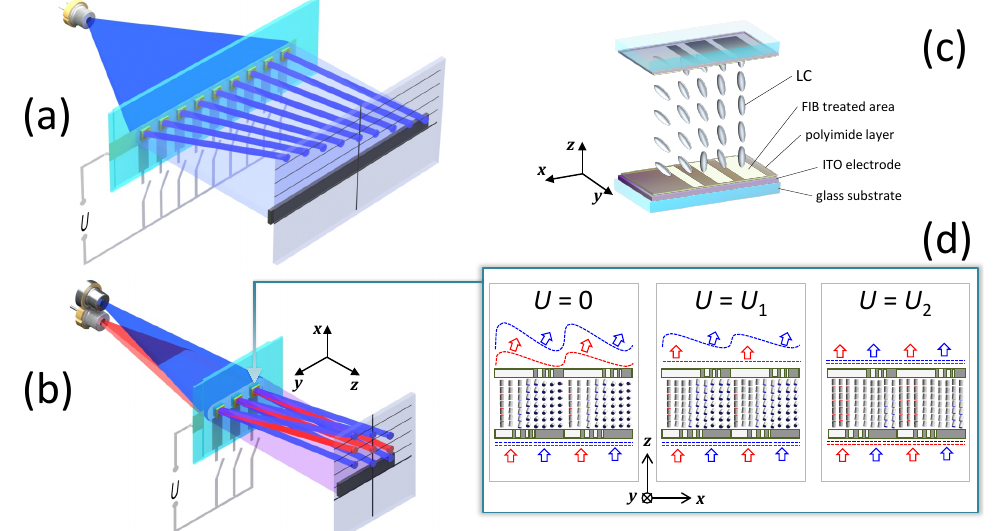
Figure 1. Advantages of multiplexed beam-steering elements based on LC-metasurfaces. Schematic of an array of 9 electrically controlled elements of different periods for parallel +1 order diffraction deflection at 9 different angles ( a ). Schematic of an array of 3 multiplexed metasurfaces covering 9 different angles by virtue of spectral and diffractive multiplexing ( b ). Schematic of a cell containing self-assembled double-sided LC metasurface ( c ). Three operating modes of a multiplexed element based on a double-sided LC-metasurface at different voltages imparting sawtooth modulations to the blue and red light wavefronts ( d